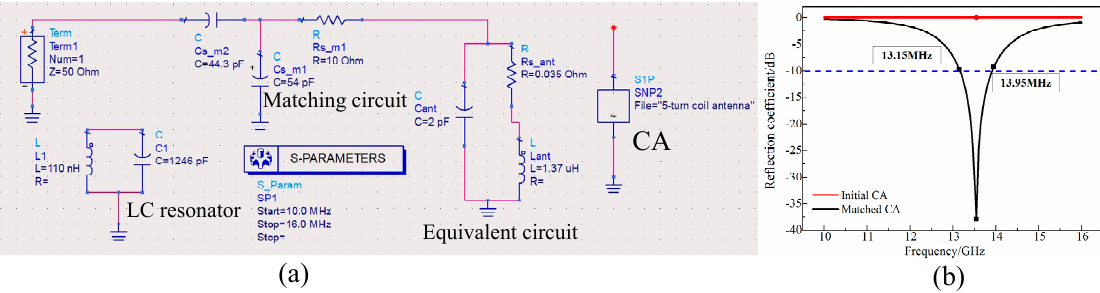
Figure 9. ( a ) The model of interim circuit; ( b ) S-parameters of equivalent circuit and interim circuit.